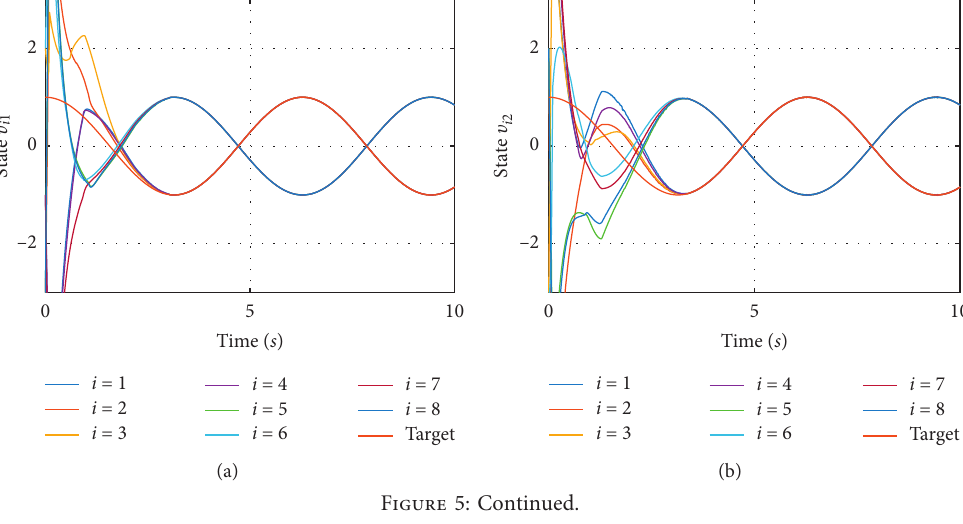
Figure 4: Pictures (a) and (b) reveal the evolution of q and 2, respectively.